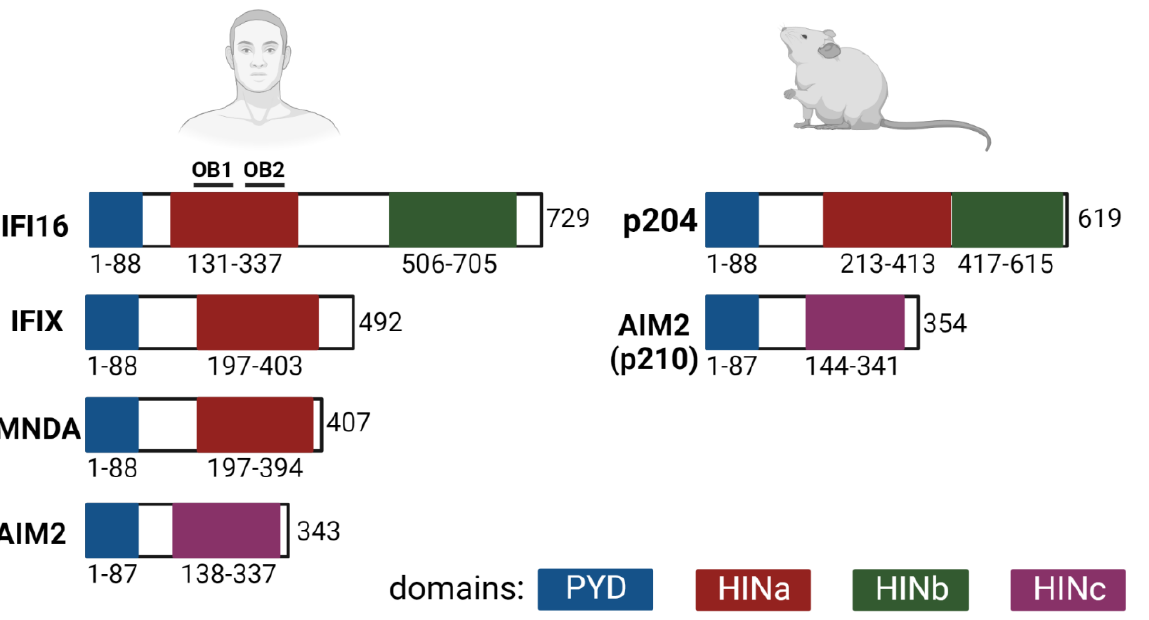
Figure 3. Domain organization of the human and mouse PYHIN family members. The PYD domain (blue), HIN domain a (red squares), HIN domain b (green), and HIN domain c (purple). The length of proteins and domains is presented. In the IFI16 HIN domain a, the position of the OBs is displayed. Created with BioRender.com.